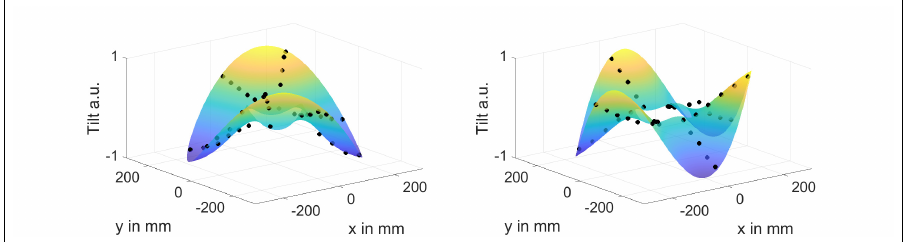
Figure 7. Complex amplitudes measured by the DGS and a fit to the theoretical mode shapes. Left : second tangential mode. Right : third tangential